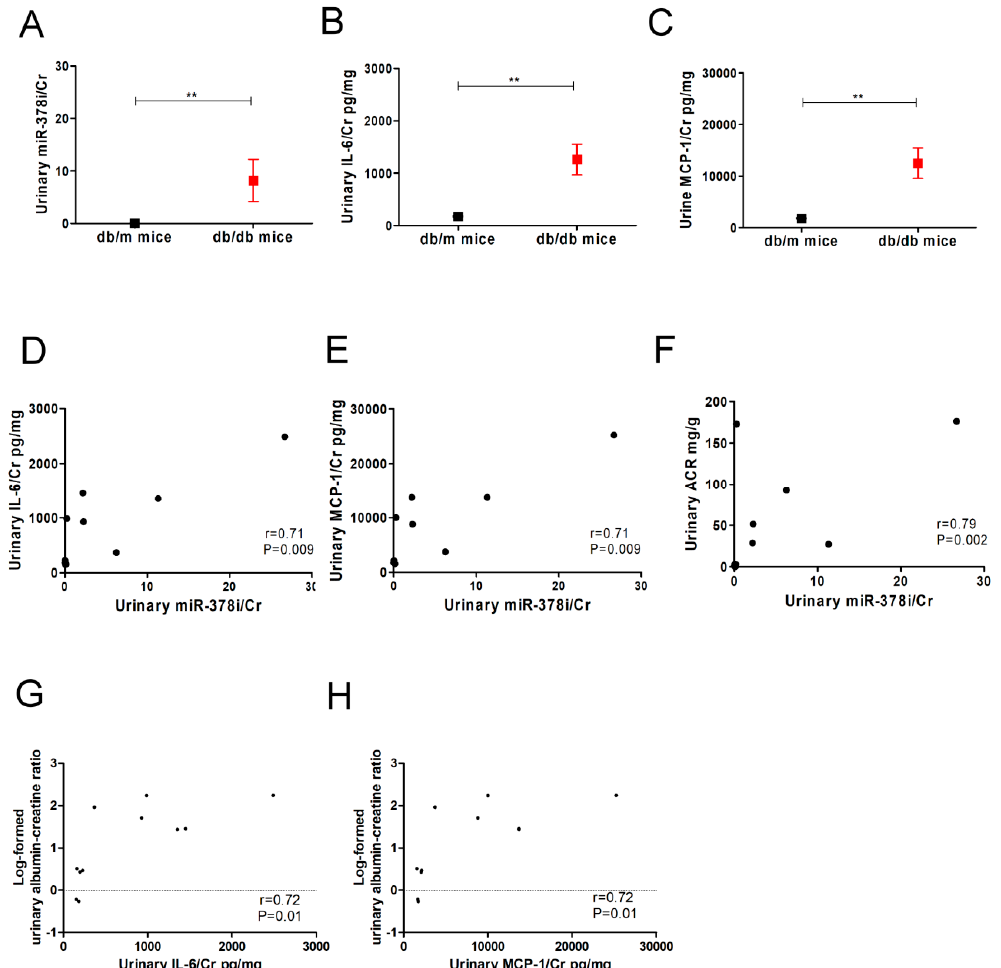
Figure 5. Urinary miR-378i is positively correlated with senescence-associated secretory phenotype (SASP) and renal dysfunction in mice. ( A ) Urinary miR-378i levels were higher in db/db mice ( n = 6) compared to db/m mice ( n = 6). Urinary SASP levels, including interleukin-6 (IL-6) ( B ) and monocyte chemoattractant protein-1 (MCP-1) ( C ) were higher in db/db mice than db/m mice. Urinary-378i was positively correlated with IL-6 ( D ) and MCP-1 ( E ) respectively. High urinary miR-378i ( F ), IL-6 ( G ), and MCP-1 ( H ) were significantly correlated with log-formed urinary albumin-creatinine ratio (ACR) in mice. Exosomal miR-378i in the urine of mice was isolated, then assessed by quantitative real-time PCR normalized to a reference control. Magnetic Luminex ® Assay was used to assess IL-6 and MCP-1 in the urine of mice. Urine albumin was measured using immunoturbidimetric assay, and urine creatinine was determined by an enzymatic method. The bar graph represents the mean ± S.E.M. ** p < 0.01 by Student t test, and p -value of correlation was analyzed by Spearman analysis. The unit of Cr as mg/dL. The unit of IL-6 and MCP-1 as pg/mL. Cr: